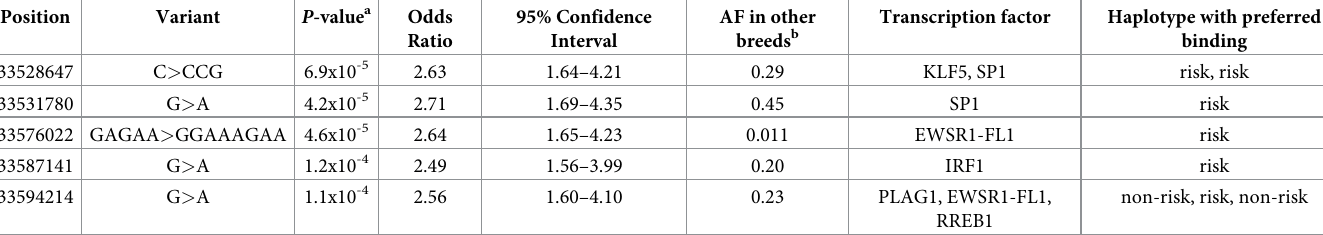
Table 3. Variants associated with histiocytic sarcoma and predicted to alter transcription factor binding